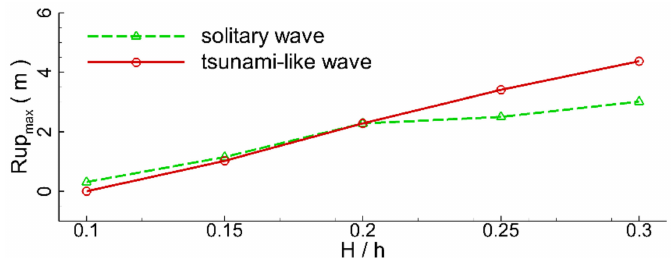
Figure 19. Comparisons of variations in maximum runup height with incident wave height.